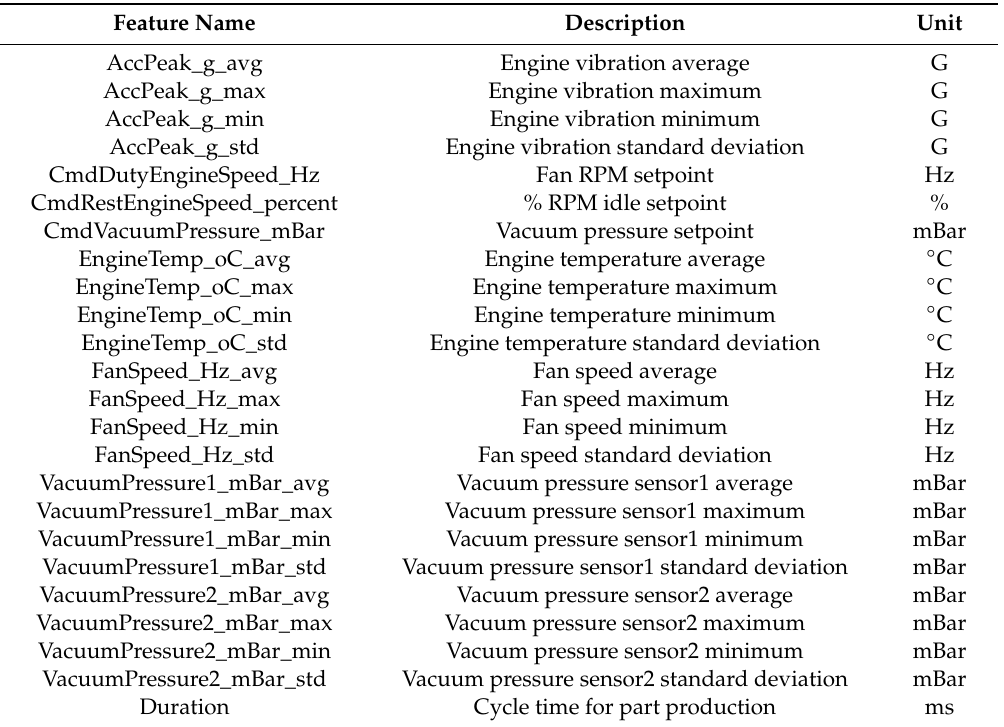
Table 2. Cyclone features. Variables gathered per manufacturing cycle.